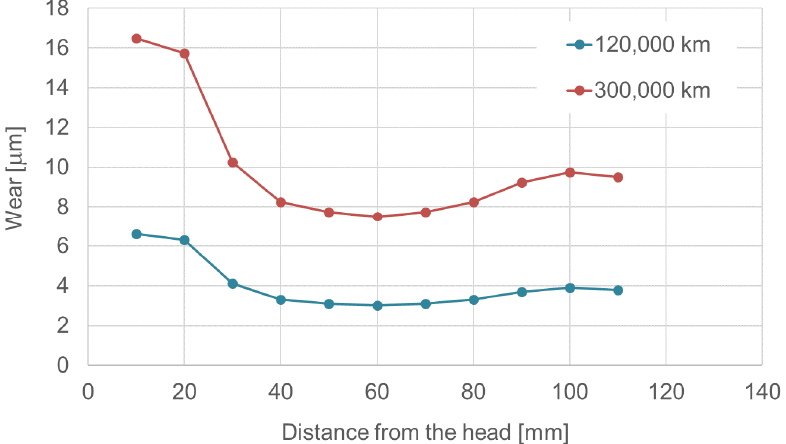
Figure 4. Wear of the cylinder liner.